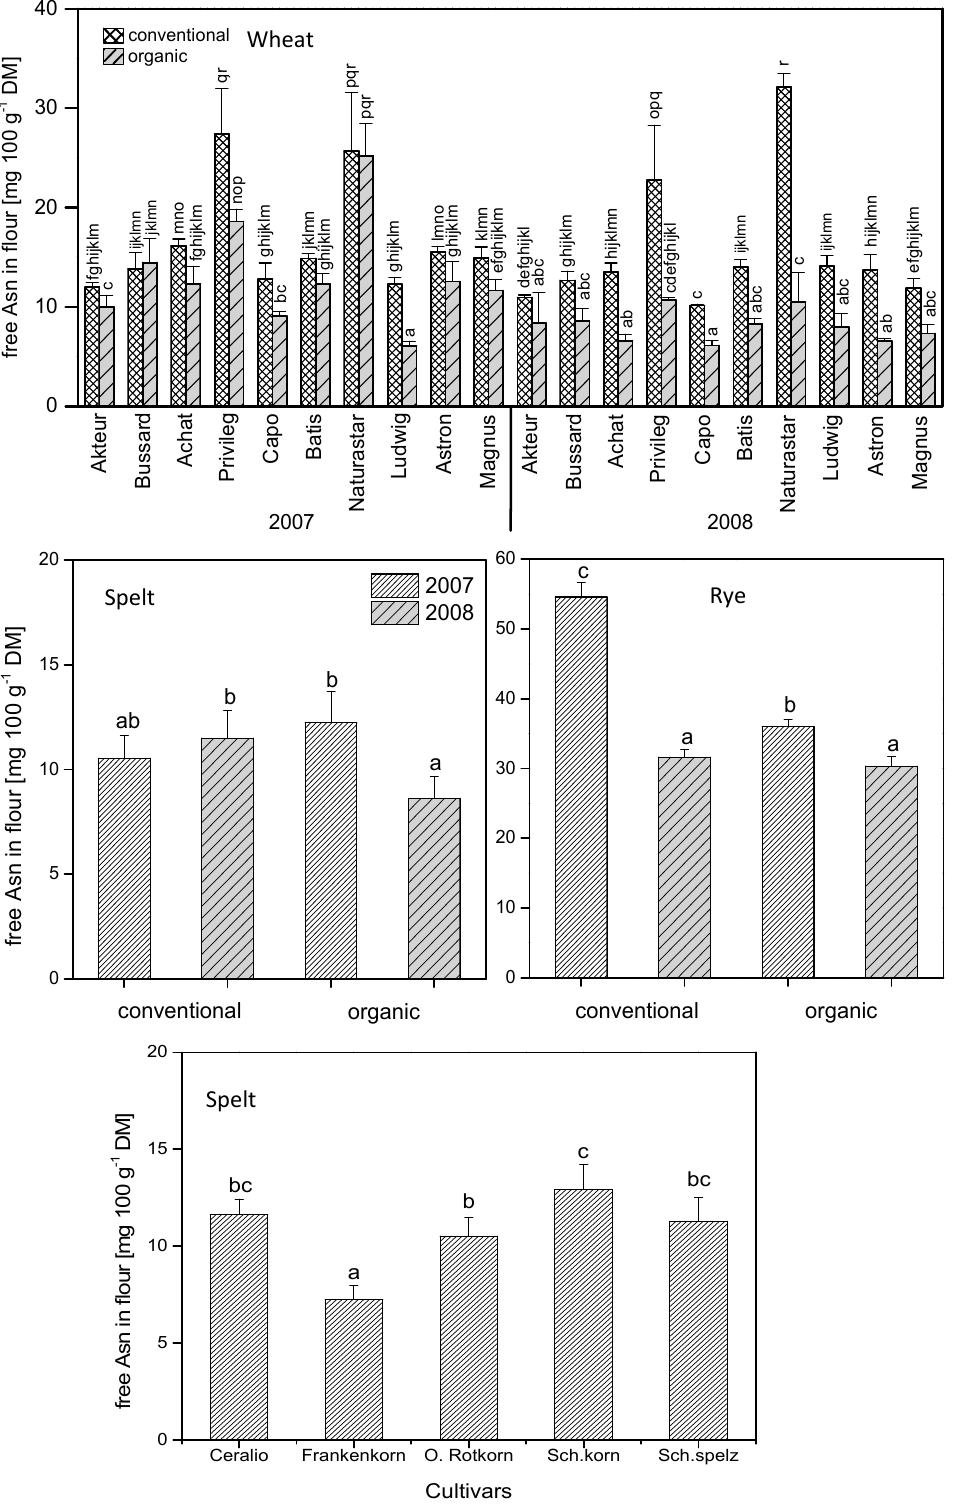
Figure 1. Free Asn content separated by species (wheat, spelt, rye), cropping system (organic, conventional), year (2007, 2008) and cultivars in dependence of their significant highest order interaction. Columns with di ff erent letters within cropping system and year indicate significant di ff erences ( α = 0.05, t